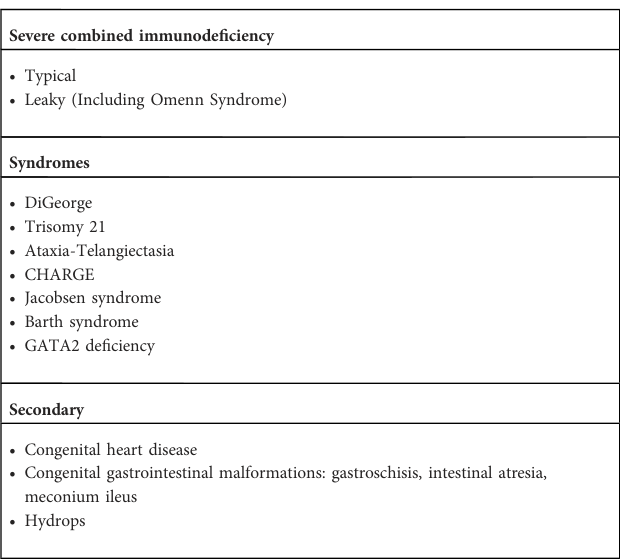
Table adapted from Currier R, Puck JM. SCID newborn screening: What we ’ ve learned. J Allergy Clin Immunol . 2021 Feb;147(2):417 –